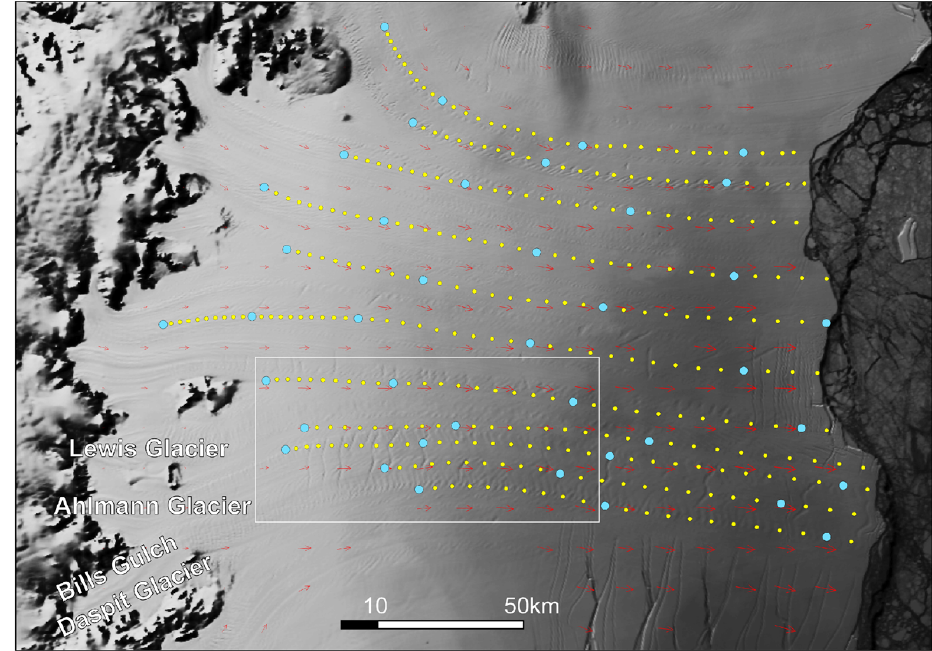
Fig. 10. Streamlines calculated from the 2006–2009 displacement measurements. Yellow dots are separated by 10 years of displacement and blue dots by 100 years of displacement. Underlying MODIS image is from 2008 and is preprocessed by Scambos et al. (2009).